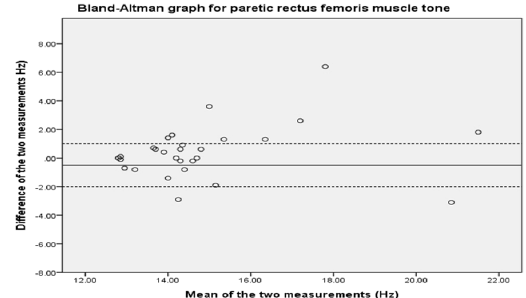
Figure 3. Bland-Altman analysis plot for rectus femoris.